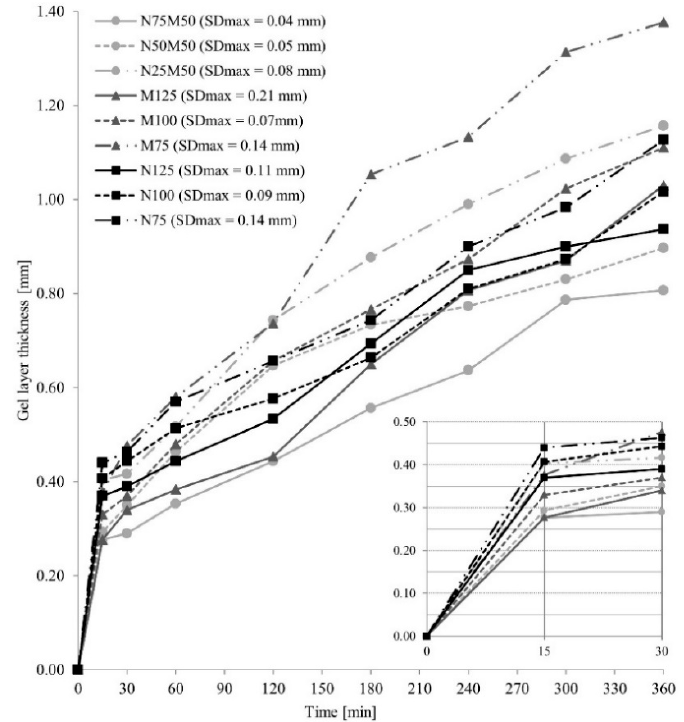
Figure 6. The gel layer thickness of the HPMC matric tablets. Comparing the samples with 10 and 20% HPMC, the proportion of HPMC (the matrix filler amount: 50 and 40%, respectively), a broader gel layer was formed in the NEU matrix tablets after 15 min compared to the corresponding MCC samples (0.28 mm for M125, 0.37 mm for N 125, 0.33 mm for M100, and 0.41 mm for N100). Still, a lower